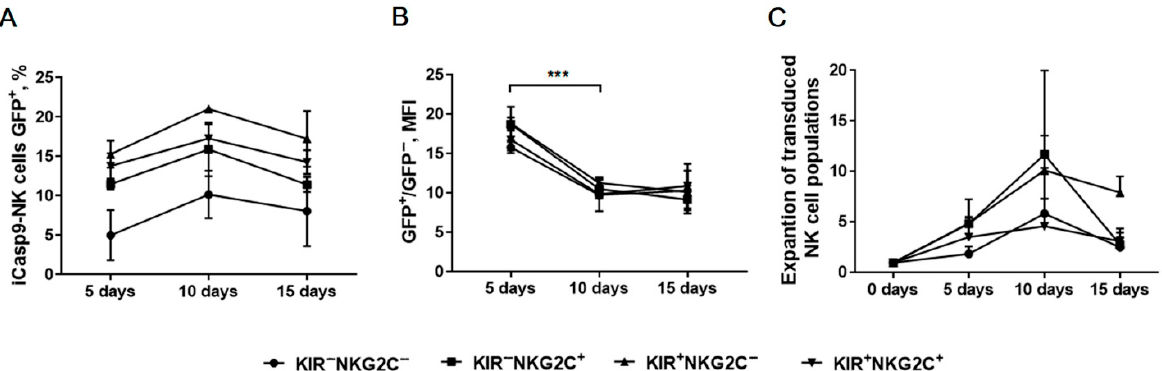
Figure 7. The dynamics of the GFP + iCasp9-NK cells, n = 2 (donors 2 and 3). ( A ) The dynamics of the proportion of the GFP + iCasp9-NK cells in the indicated subsets. ( B ) A comparison of GFP mean fluorescence intensity (MFI) normalized on the MFI of the GFP − NK cells among the indicated NK cell populations during long-term cultivation. ( C ) A comparison of the iCasp9-NK cell number after the transduction, normalized on the initial number of transduced cells. ( A – C ) Statistical analysis was performed using a paired t -test (*** p < 0.001); means ± SE are shown.